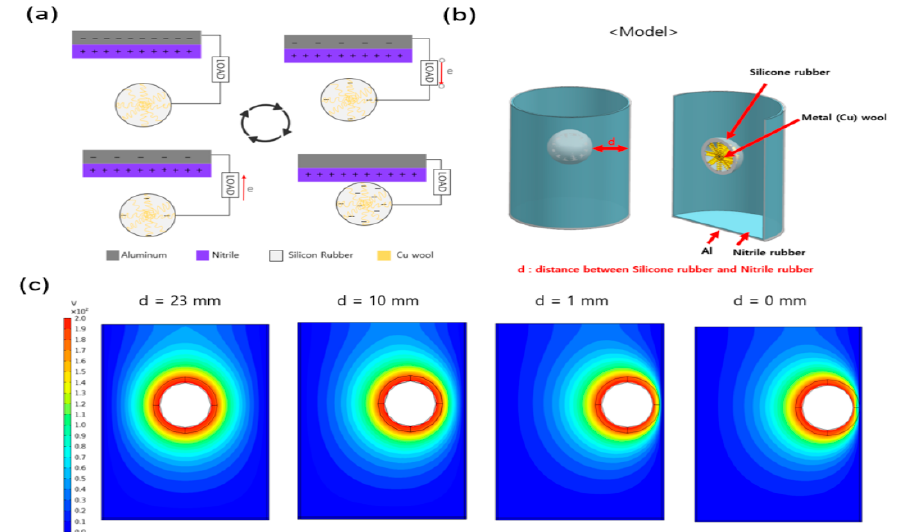
Figure 2. Contact- and separation-mode mechanism and COMSOL simulation of the P-TENG cylinder and Dragon Skin (D.S.) ball: ( a ) schematic of the contact- and separation-mode mechanism, ( b ) diagram showing modeling for the simulation, and ( c ) gradient image depicting COMSOL simulation results.